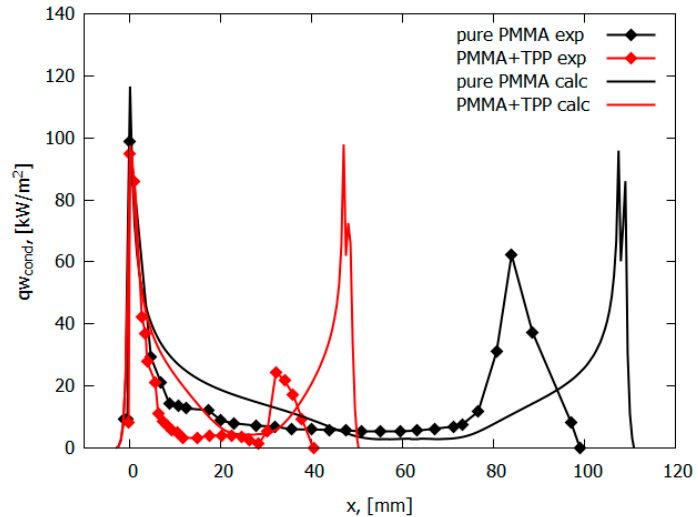
Figure 10. Conductive heat flux profiles for PMMA and PMMA + 10%TPP. Table 2. Kinetic parameters of pyrolysis and combustion macroreaction rates in the model (horizontal flame spread